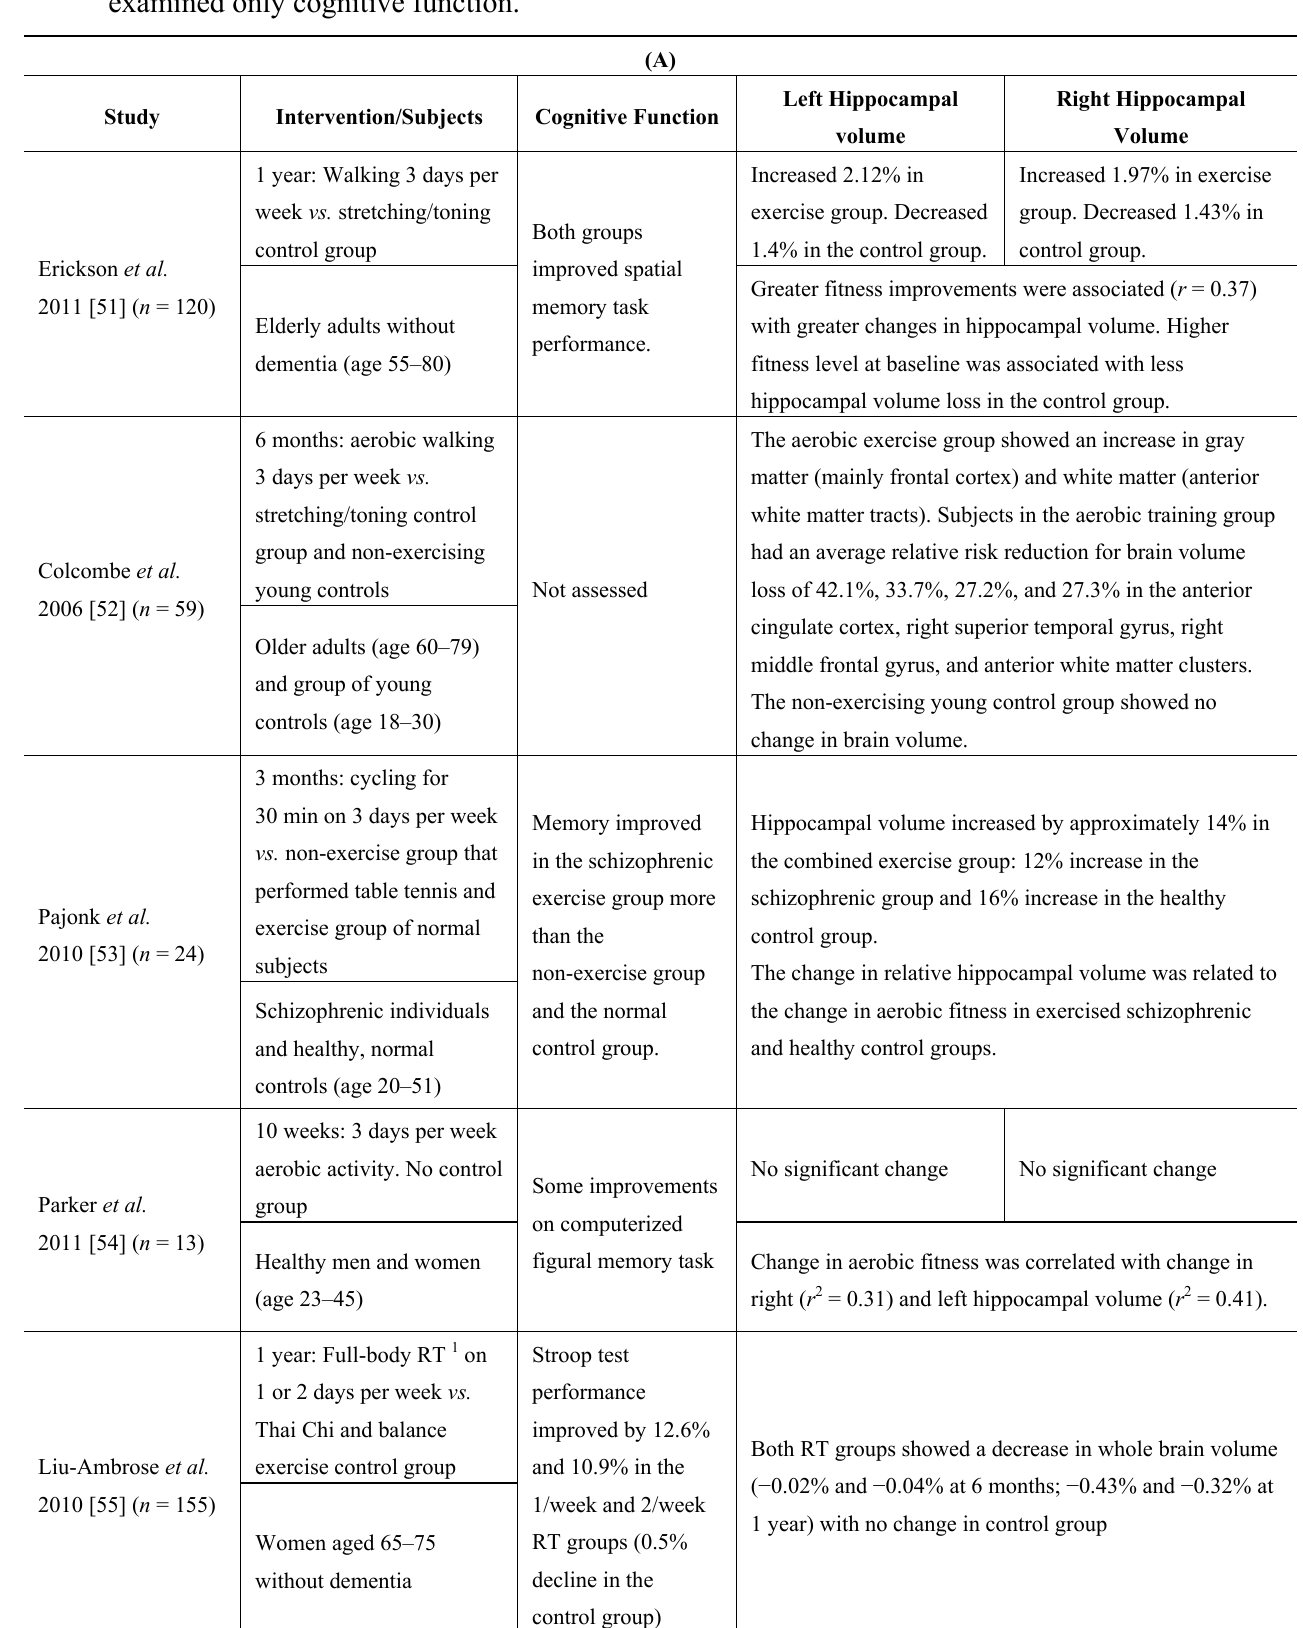
Table 2. Summary of interventional studies that examined physical activity, fitness, and brain function. ( A ) includes studies that examined brain volumes; ( B ) includes studies that examined only cognitive